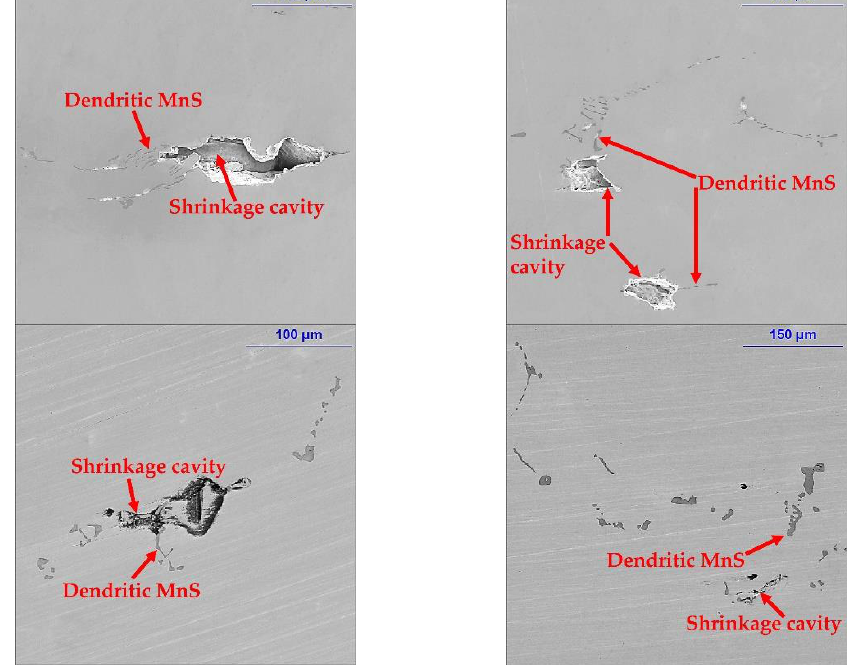
Figure 13. Relationship between MnS inclusions and shrinkage cavities in the medium carbon structural steel 45#.